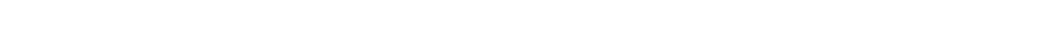
Frontiers in Neurology | Brain Imaging